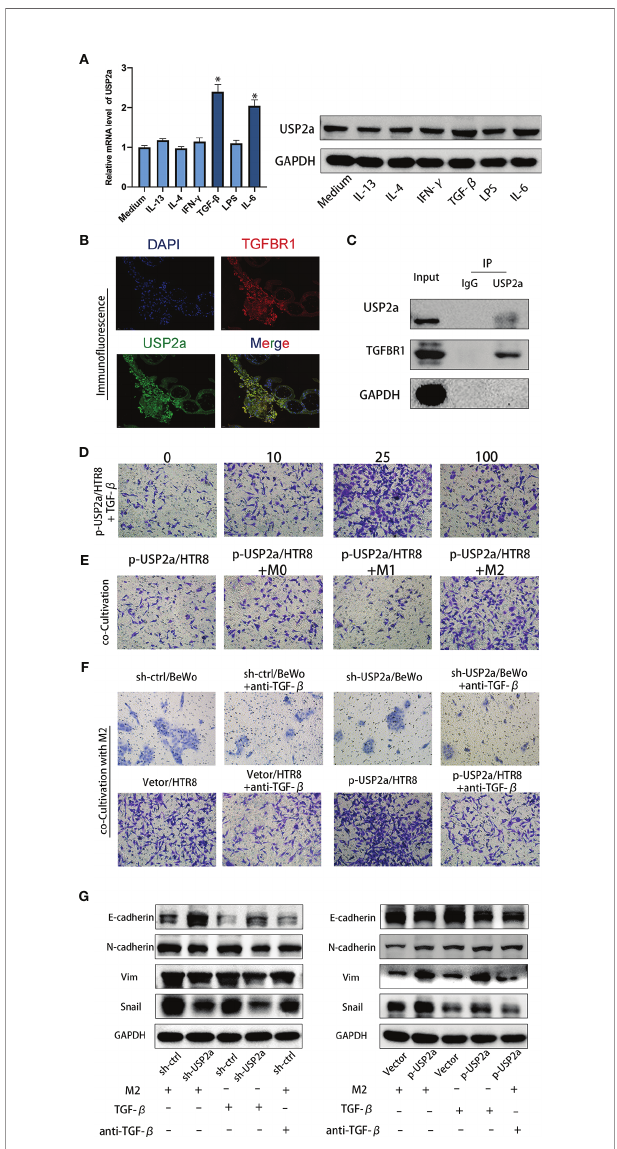
FIGURE 6 | M2 Macrophage-secreted TGF- b cooperate with USP2a in trophoblasts to promote invasion. (A) Western blot and quantitative RT-PCR analysis of USP2a expression in HTR8 treated with IFN- g , IL-13, IL-4, IL-6, LPS, or TGF- b for 24 hours. (B) Immunostaining for TGFBR1 and USP2a in villous from normal pregnancy woman (Scale bar = 20 m m). (C) co-IP assays of the interaction between USP2a and TGFBR1 in p-USP2a/HTR8. (D) Cell invasion capacity in HTR8 alone, HTR8 with 10ng/ml, 25ng/ml, or 100ng/ml rhTGF- b by transwell system. (E) Cell invasion capacity in p-USP2a/HTR8 alone, p-USP2a/HTR8 co-cultured with M0 macrophage, co-cultured with M1 macrophage, and co-cultured with M2 macrophage by transwell system. (F) Cell invasion capacity in sh-Ctrl/BeWo, sh-USP2a/BeWo, Vector/HTR8, p-USP2a/HTR8 co-cultured with M2 macrophage or above cells co-cultured with TGF- b depleted M2 macrophage were determined by transwell system, respectively. (G) Western blot assay of EMT proteins in sh-Ctrl/BeWo, sh- USP2a/BeWo, Vector/HTR8, p-USP2a/HTR8 co-cultured with M2 macrophage or above cells co-cultured with TGF- b depleted M2 macrophage were determined by transwell system, respectively. * P < 0.05, vs. HTR8. DAPI staining blue; TGFBR1 staining red; USP2a staining green. Representative photographs of invasive cells (magni fi cation, ×200) are